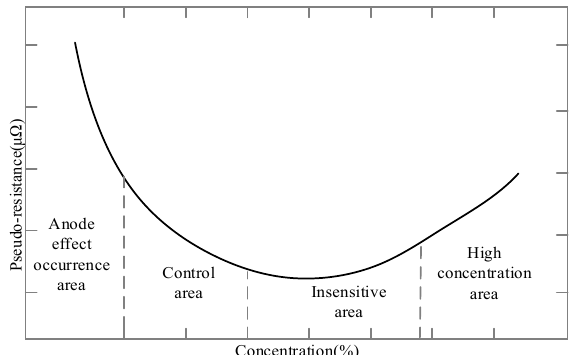
Figure 7. The relationship between cell pseudo-resistance and alumina concentration.